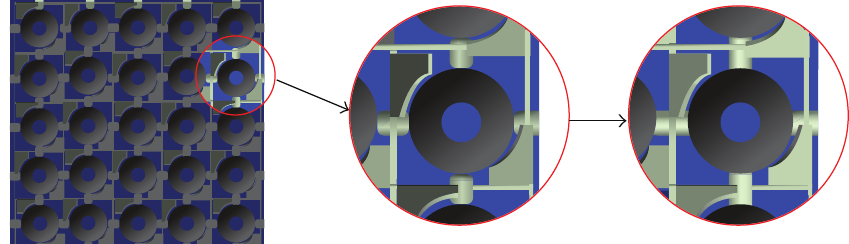
Figure 5: Geometrical simplified model of the grid